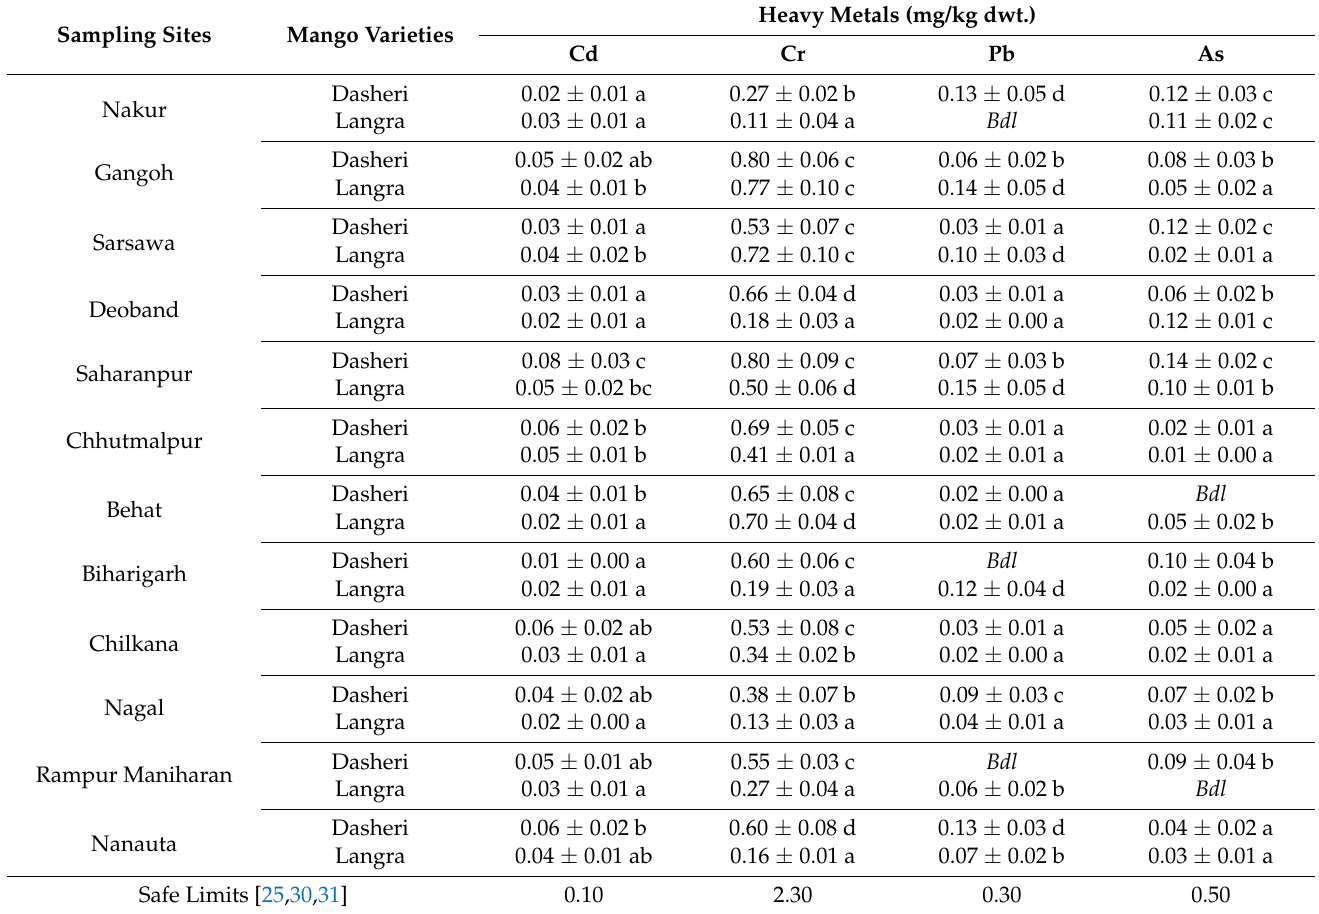
Table 2. Heavy metal concentration (mean ± SD; n = 5) in two mango fruit ( M. indica ) variety samples collected from Saharanpur district, Uttar Pradesh,